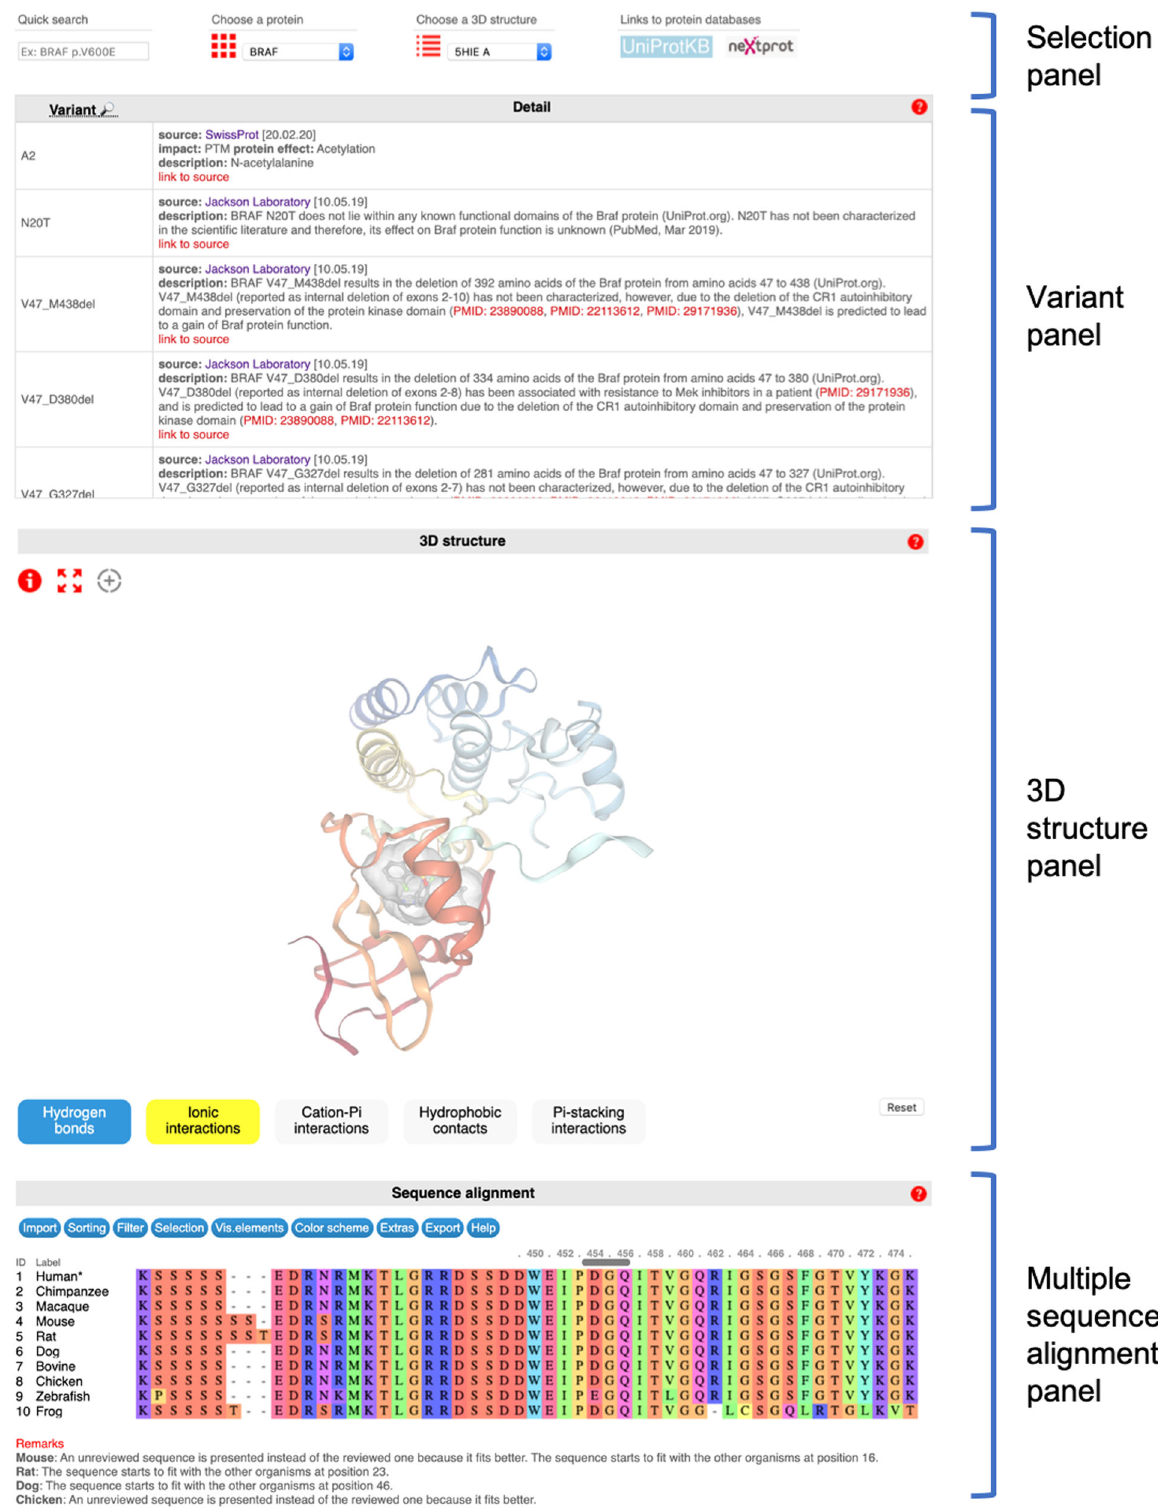
Fig. 2 General structure of the website. De fi nition and position of the four will automatically focus the two others on the same residue. A more detailed description is provided below. Each of the last three panels is accompanied by a help button, in the form of a question mark icon on the right side of the panel header, which opens a pop-up description of the main commands.